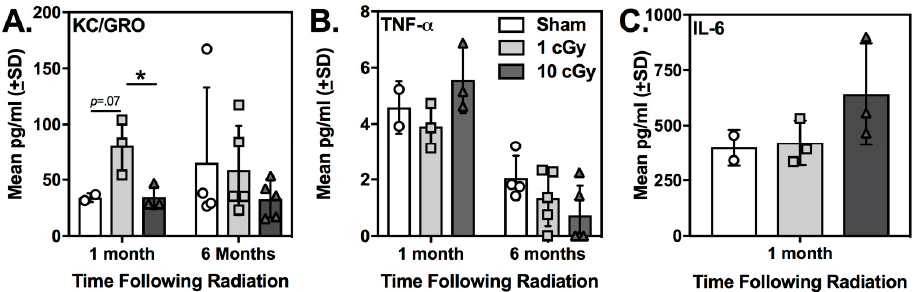
Figure 5. Plasma cytokine levels in sham control ( n = 2–4), 1 cGy ( n = 3–5), and 10 cGy ( n = 3–5) exposed rats measured either one month or six months following exposure. ( A ) Mean plasma KC / GRO levels (pg / ml) were significantly greater in the 1 cGy group at one month following exposure compared to the 10 cGy group (* p = 0.05) and trended towards significance compared to the sham controls ( p = 0.07). ( B ) Mean plasma TNF- α levels were unaffected by radiation exposure. ( C ) Mean plasma IL-6 levels did not differ among the groups at one month following exposure.